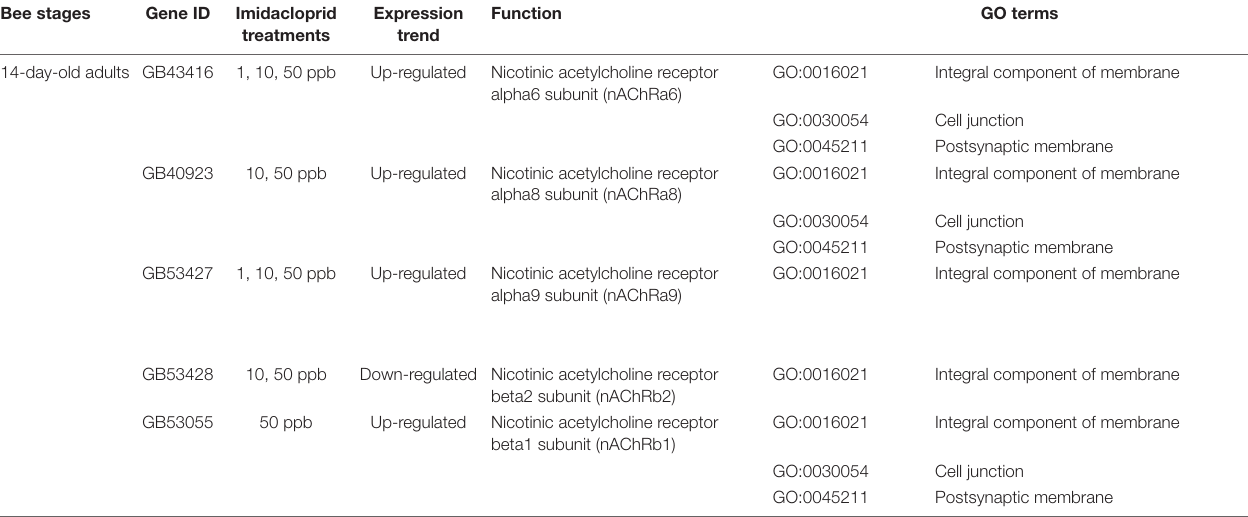
TABLE 4 | Differentially expressed nAChRs family subunit genes in 14-day-old adults with 1-, 10-, and 50-ppb imidacloprid treatments. Bee